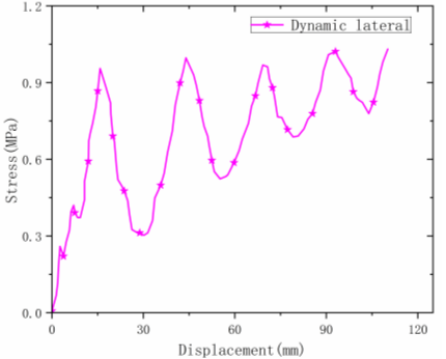
Figure 13. Lateral dynamic stress – strain curve.